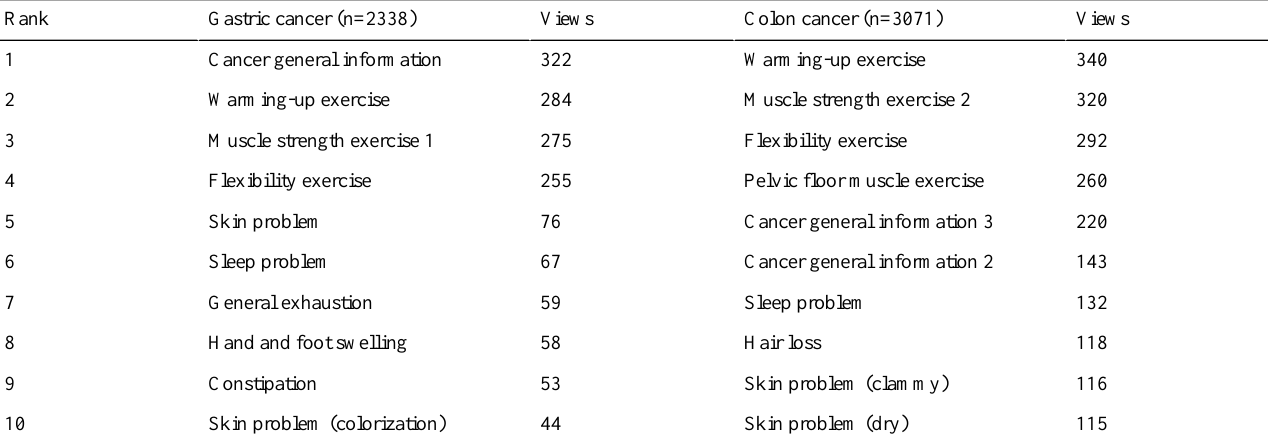
Table 6. Health education content views by participants.